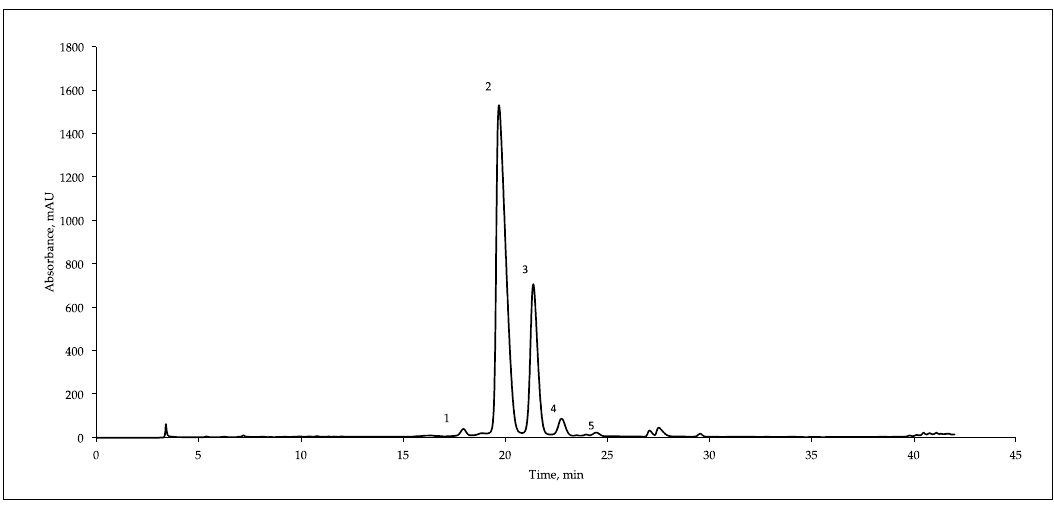
Figure 1. Typical HPLC / DAD / MS analysis (recorded at 520 nm) of the anthocyanins present in mulberry fruit extracts ( M. nigra ). (1) cyanidin-3- O -sophoroside, (2) cyanidin-3- O -glucoside, (3) cyanidin-3- O -rutinoside, (4) pelargonidin -3- O -glucoside and (5) pelargonidin -3- O -rutinoside.